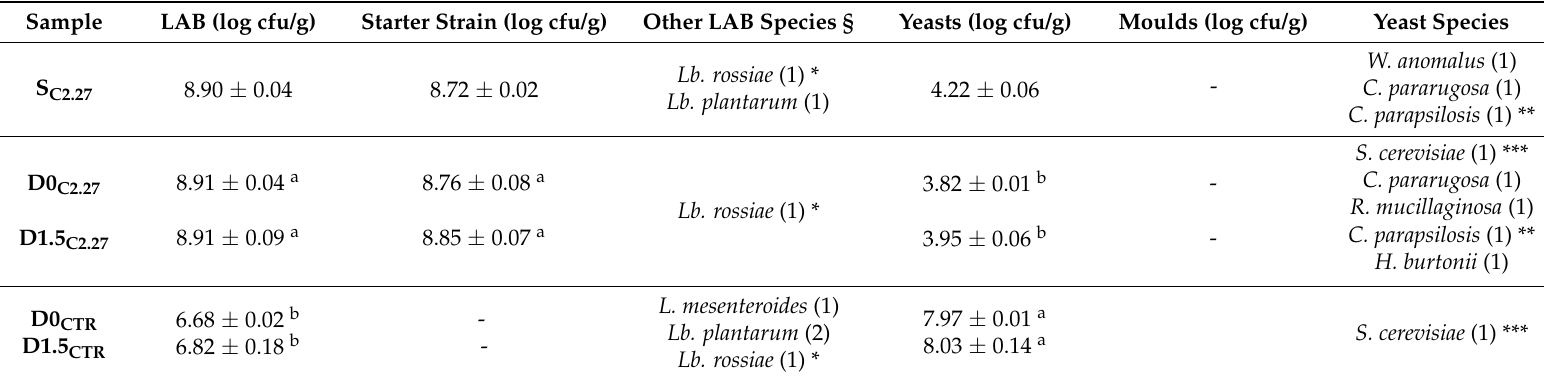
Data represent the means of three independent experiments ± standard error. a,b Values refer to bread doughs in the same column, where different letters differ significantly ( p < 0.05); Lb. , Lactobacillus ; L. , Leuconostoc ; C. , Candida ; S. , Saccharomyces ; R. , Rhodotorula ; H. , Hyphopichia ; W. , Wickerhamomyces . § Bacterial speciesidentified in liquid sourdough and bread doughs